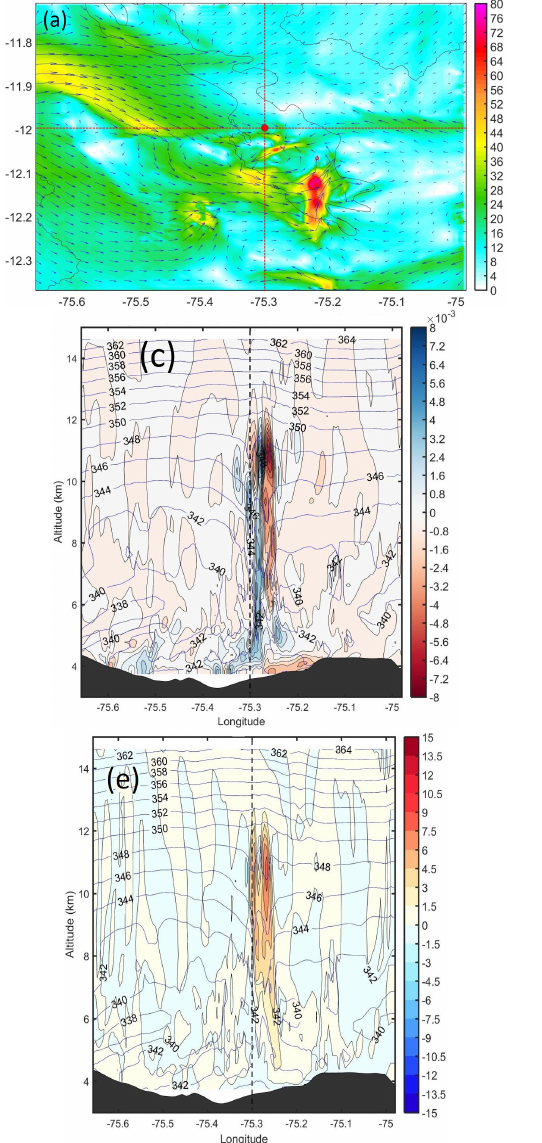
Figure 14. ( a ) Horizontal flow of vertically integrated total column of water vapor flux (kg m − 1 s − 1 ); ( b ) Horizontal flow of surface wind (m s − 1 ) with combined isosurface of cloud, ice, rain and hail mixing ratios ( q c + q i + q s + q h ) (0.5 g kg − 1 ). Vertical cross section of mean divergence fluxes (s − 1 ) ( c , d ) and mean vertical velocities (m s − 1 ) ( e , f ) along longitude and latitude of the Huancayo observatory showed with dotted horizontal lines in ( a ). All fields were obtained from the ARPS model (resolution: 0.5 km) at 0115 UTC (2015 LT) of 30 December,